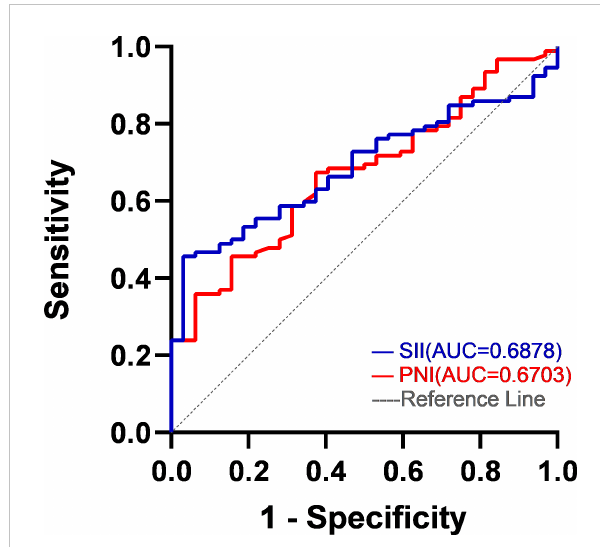
FIGURE 2 ROC curves of SII and PNI. The AUC of the SII is 0.6878. The AUC of the PNI is 0.6703.